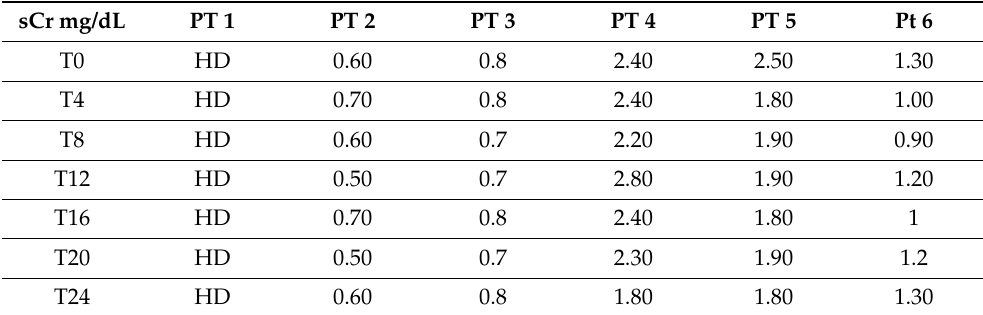
Table 4. Serum creatinine values of all patients all of the time during the treatment. TO: pre-treatment, and every other four